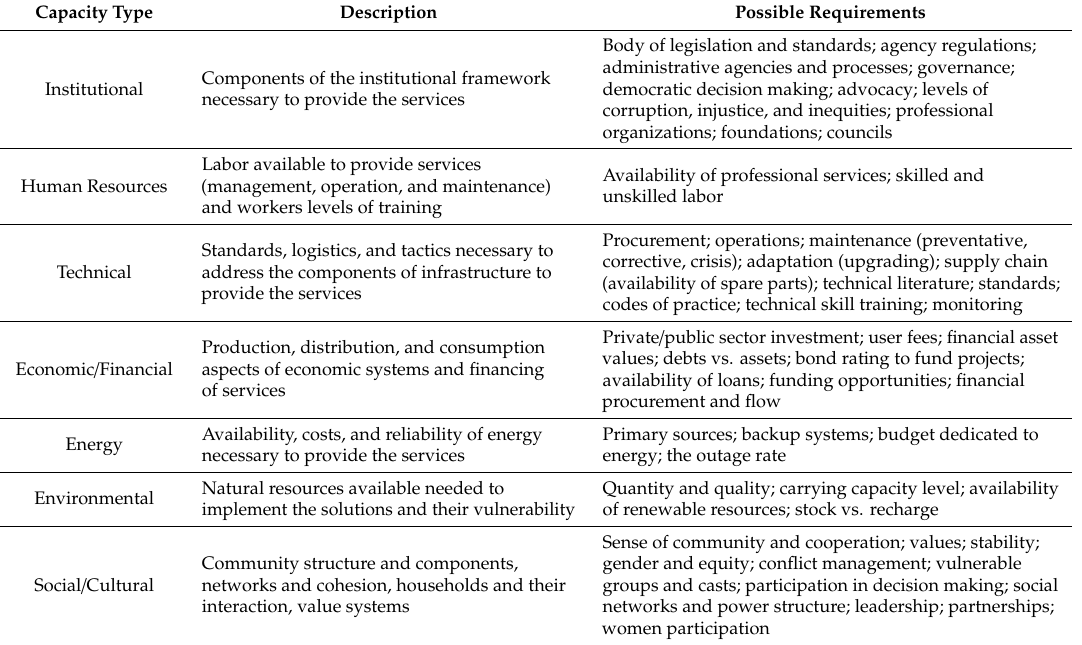
Table 3. A non-exhaustive list of capacity types and requirements (adapted from